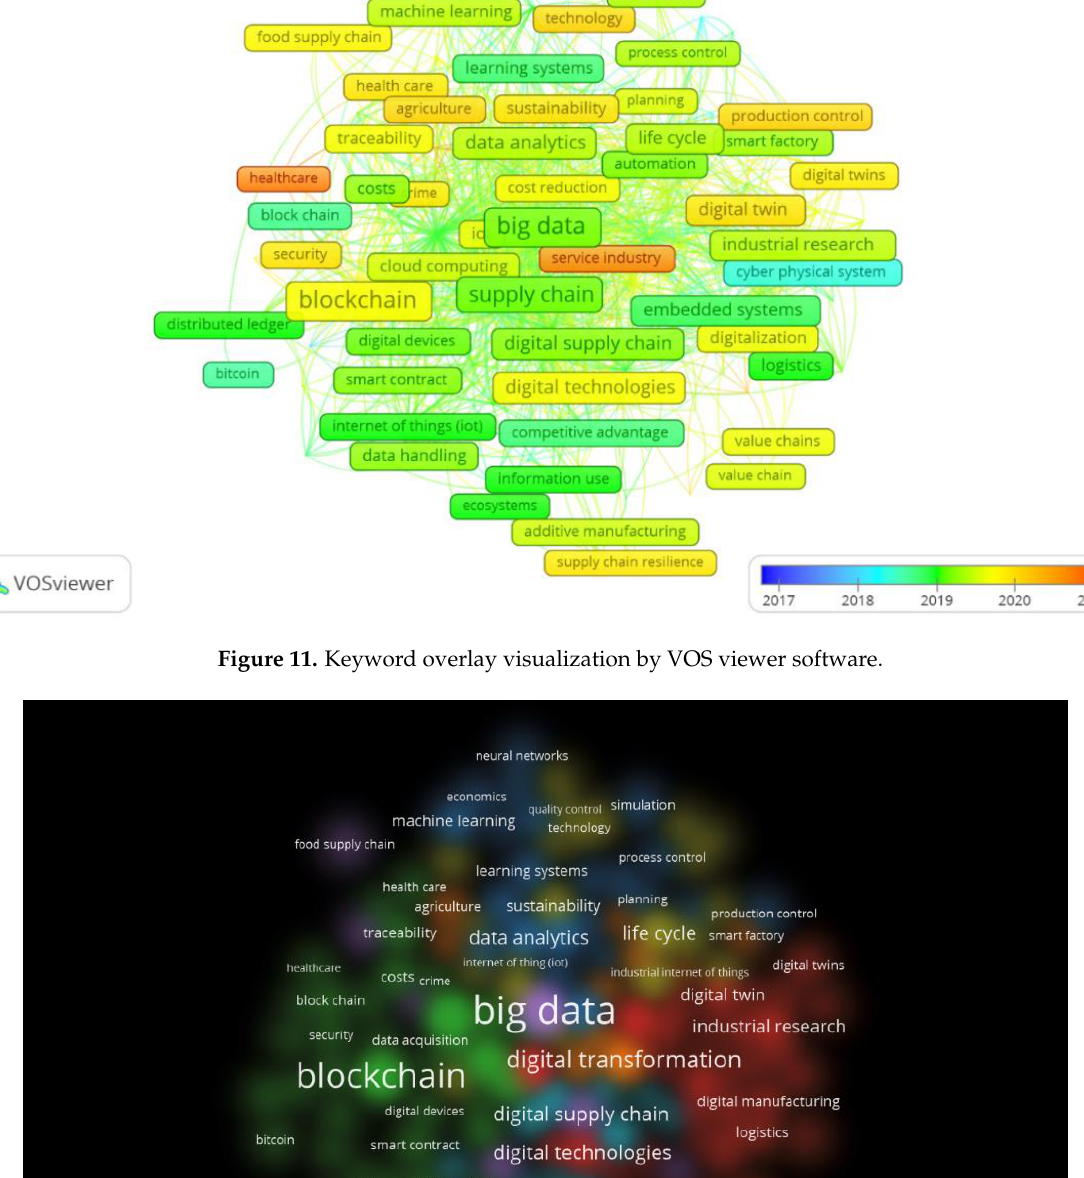
Figure 12. Cluster density visualization of trends (digital transformation and SCM).